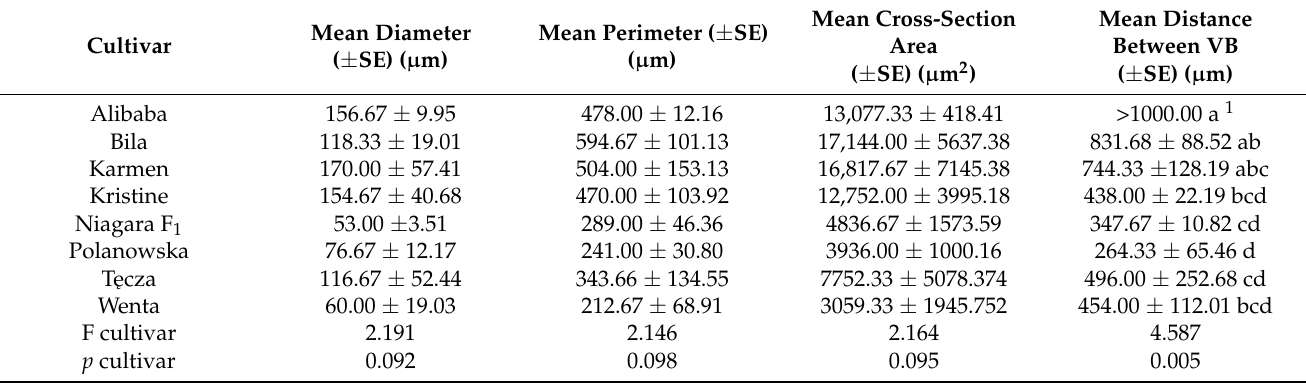
Table 9. The evaluated parameters of vascular bundles (VB) in leaves of evaluated eight different Allium cepa cultivars in 2016, df =